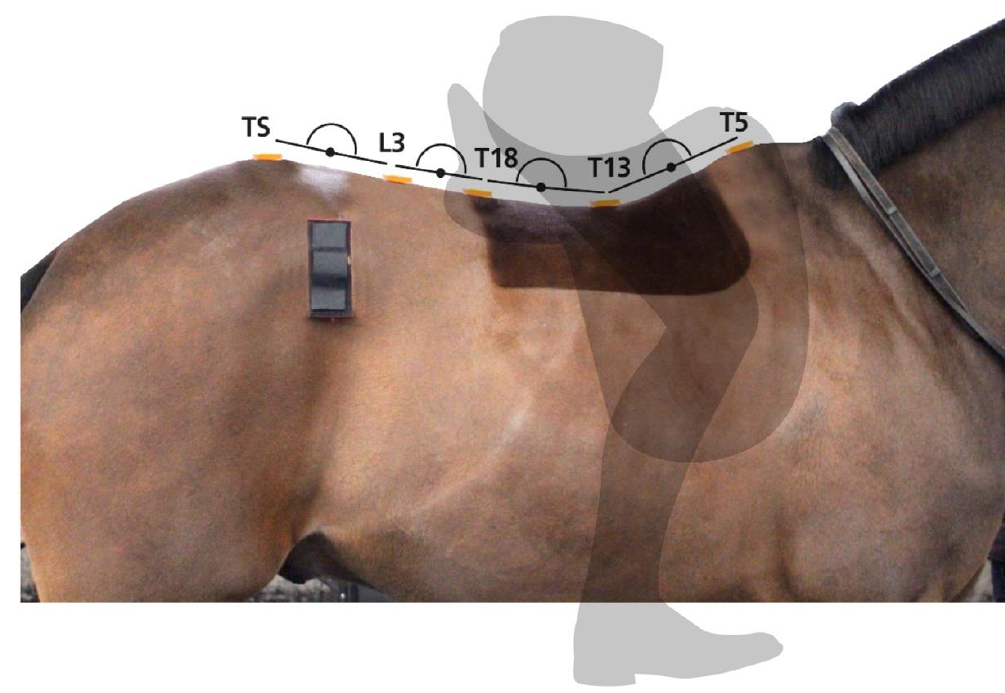
Figure 1. Inertial measurement unit (IMU) sensor locations along the midline of the thoracolumbar region beneath the saddle and rider. Sensors were glued on to the skin over thoracic and lumbar vertebrae (T5, T13, T18, L3). Sensor pouches were used for the sensors attached over the tubera sacrale and left and right tubera coxae.